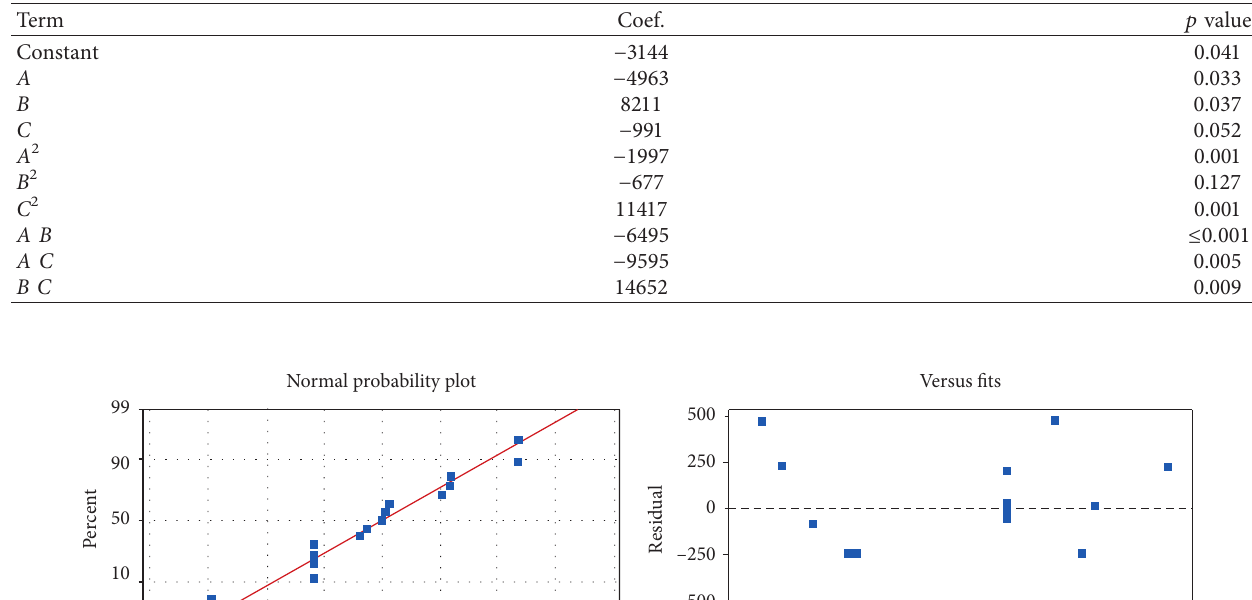
Table 7: Estimated regression coefficients for chip frequency.